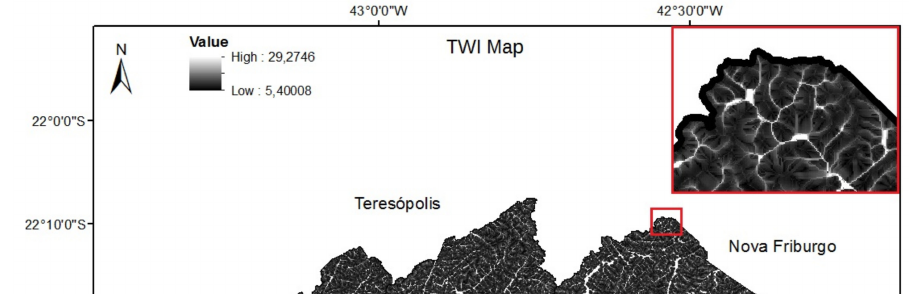
Figure A8. Flow Accumulation Map.